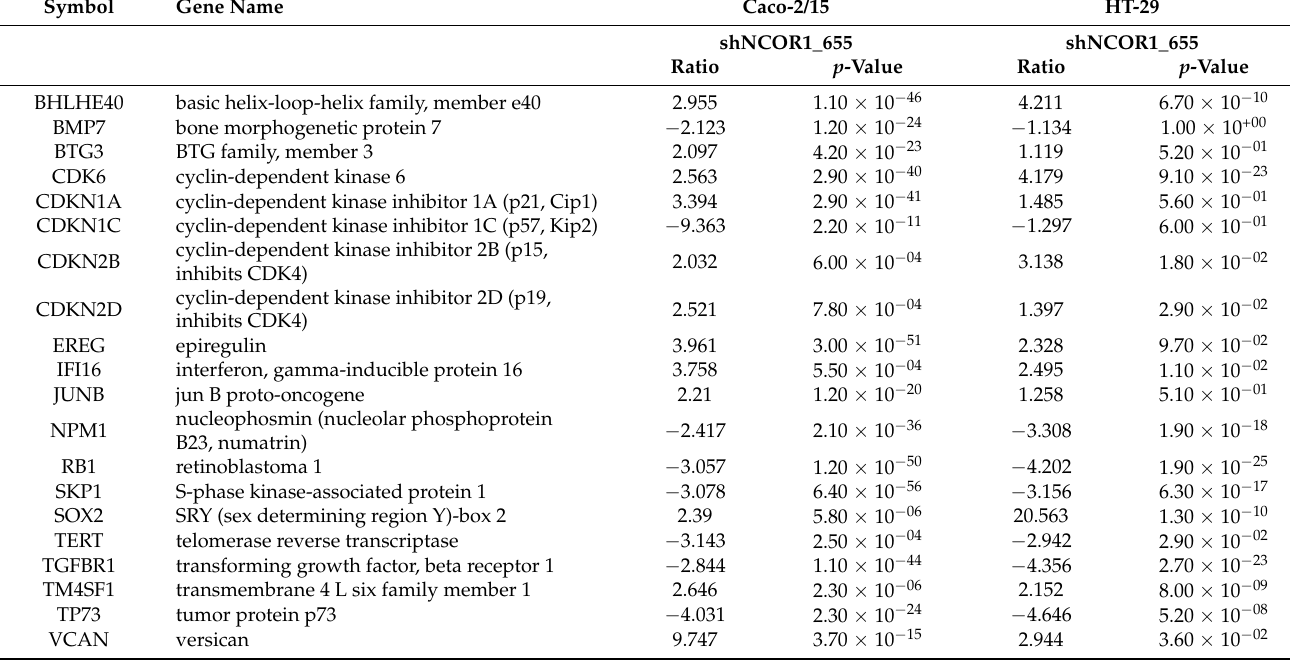
Table 1. List of genes associated with cell senescence and significantly modulated (change ratio of >2; p < 0.05) in both Caco-2/15 and HT-29 cells depleted for NCOR1